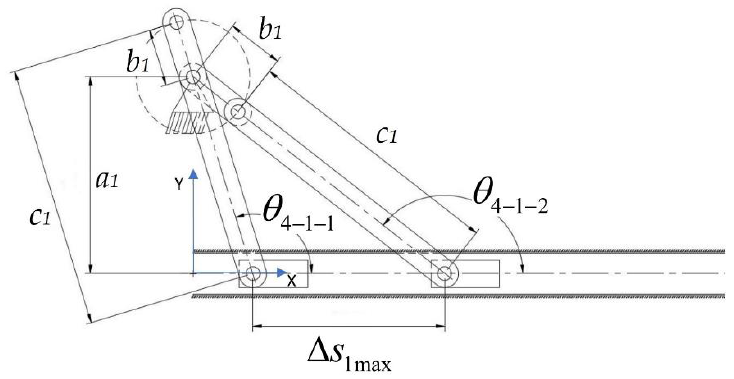
Figure 11. The Offset slider – crank mechanism poses at two dead-end points.